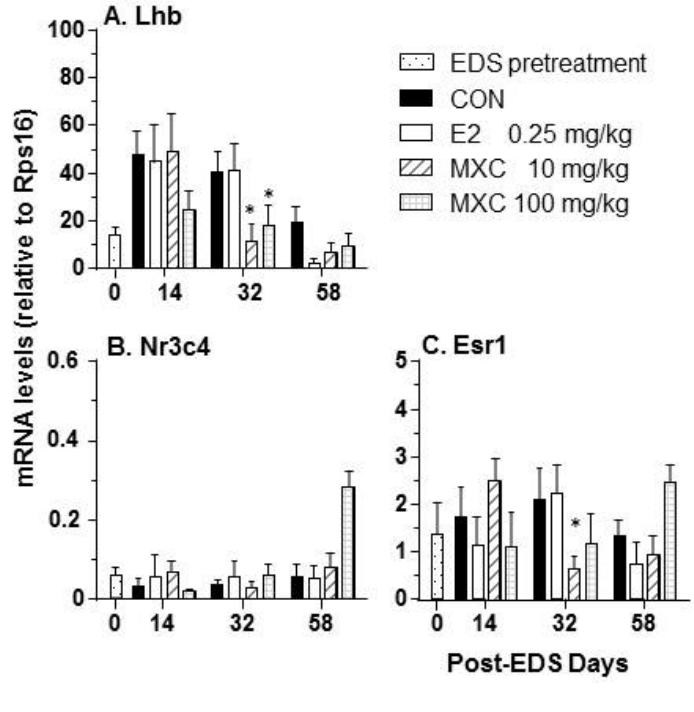
Figure 7. Quantitative PCR assay of mRNA levels in the pituitary. ( A ) Lhb ; ( B ) Nr3C4 ; ( C ) Esr1 . Mean ± SEM, n = 5. * indicates significant difference when compared to the control (CON) at each time point at p <